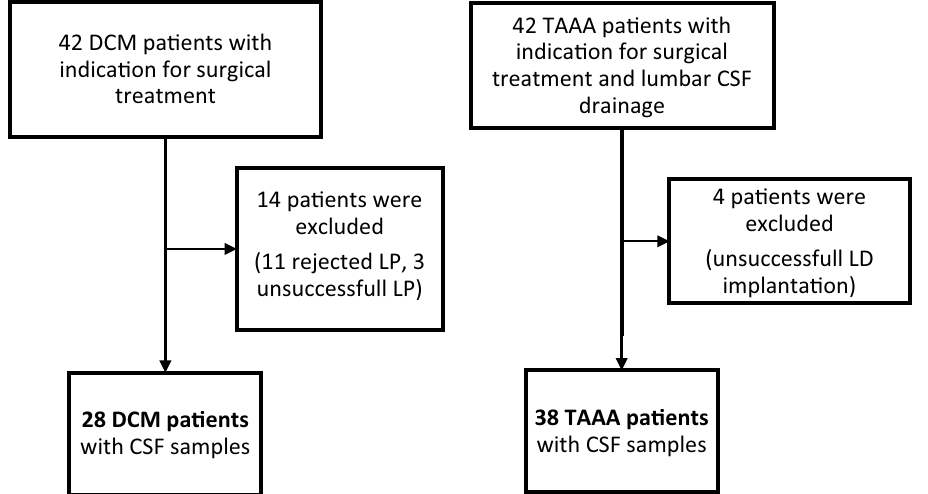
Figure 1. Flowchart of enrolled patients (DCM) and controls (TAAA) and finally included subjects. CSF cerebrospinal fluid, DCM degenerative cervical myelopathy, LD lumbar drainage, LP lumbar puncture, TAAA thoracic-abdominal aortic